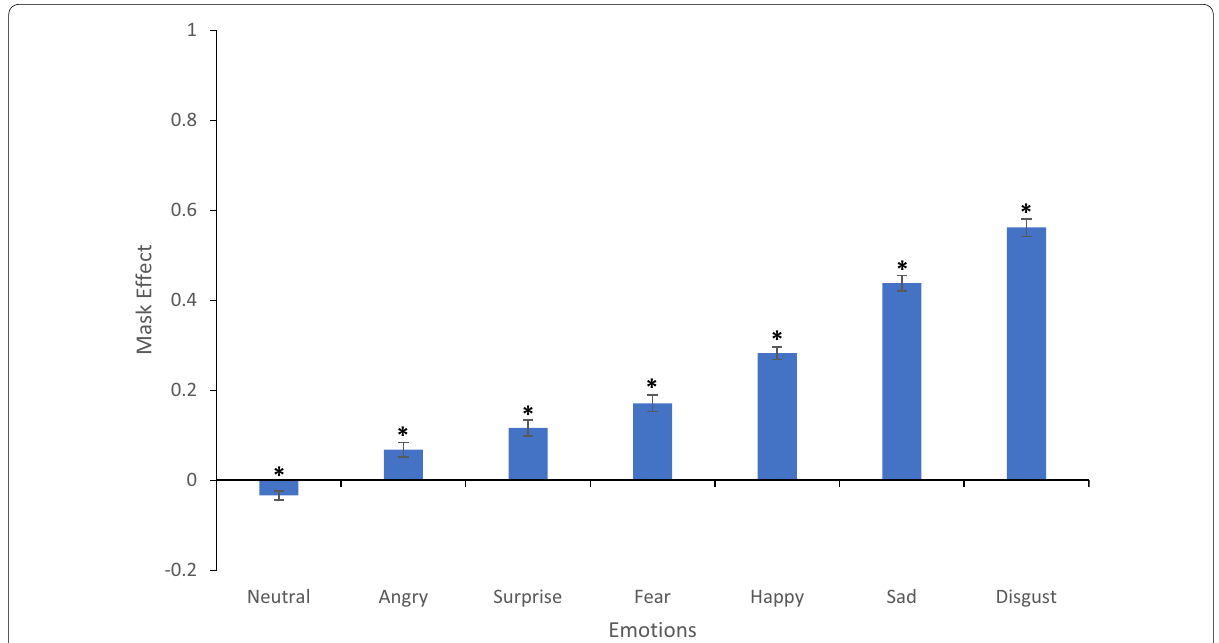
Fig. 2 The “mask effect” (i.e. the difference between unmasked and masked emotion recognition accuracy) for each emotion. *Represents a significant difference between performance for masked and unmasked faces, p < 0.05. Unmasked vs masked performance for each emotion from the paired samples t